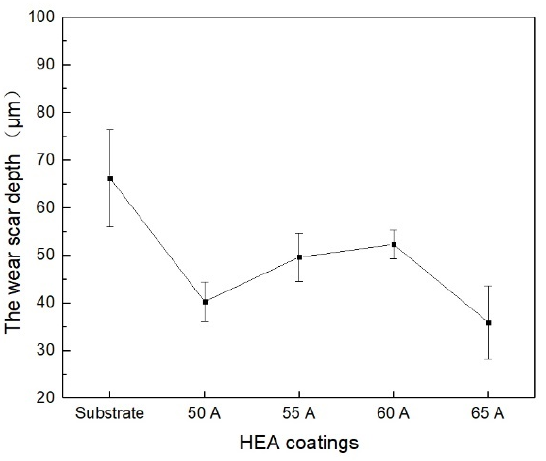
Figure 10. The wear scar depth of the substrate and the CoCrFeNiMn HEA coatings at different plasma arc currents.